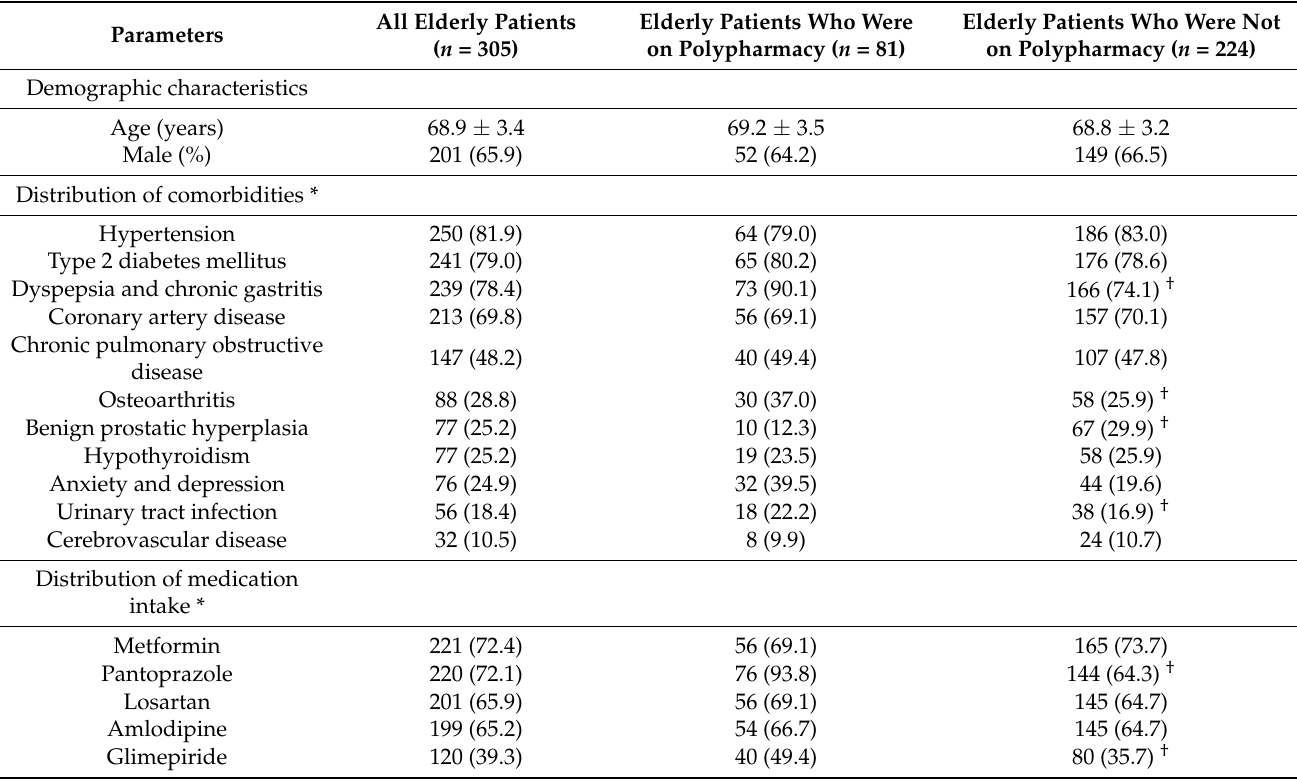
Table 1. The distribution of the background characteristics of all elderly patients, those who were on polypharmacy, and those who were not are enumerated in Table